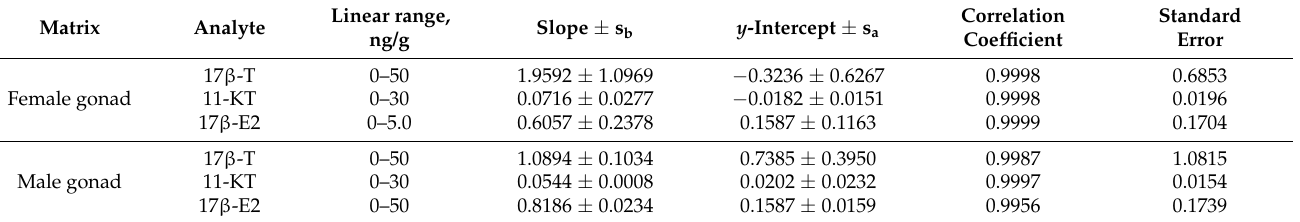
Table 3. Calibration parameters a